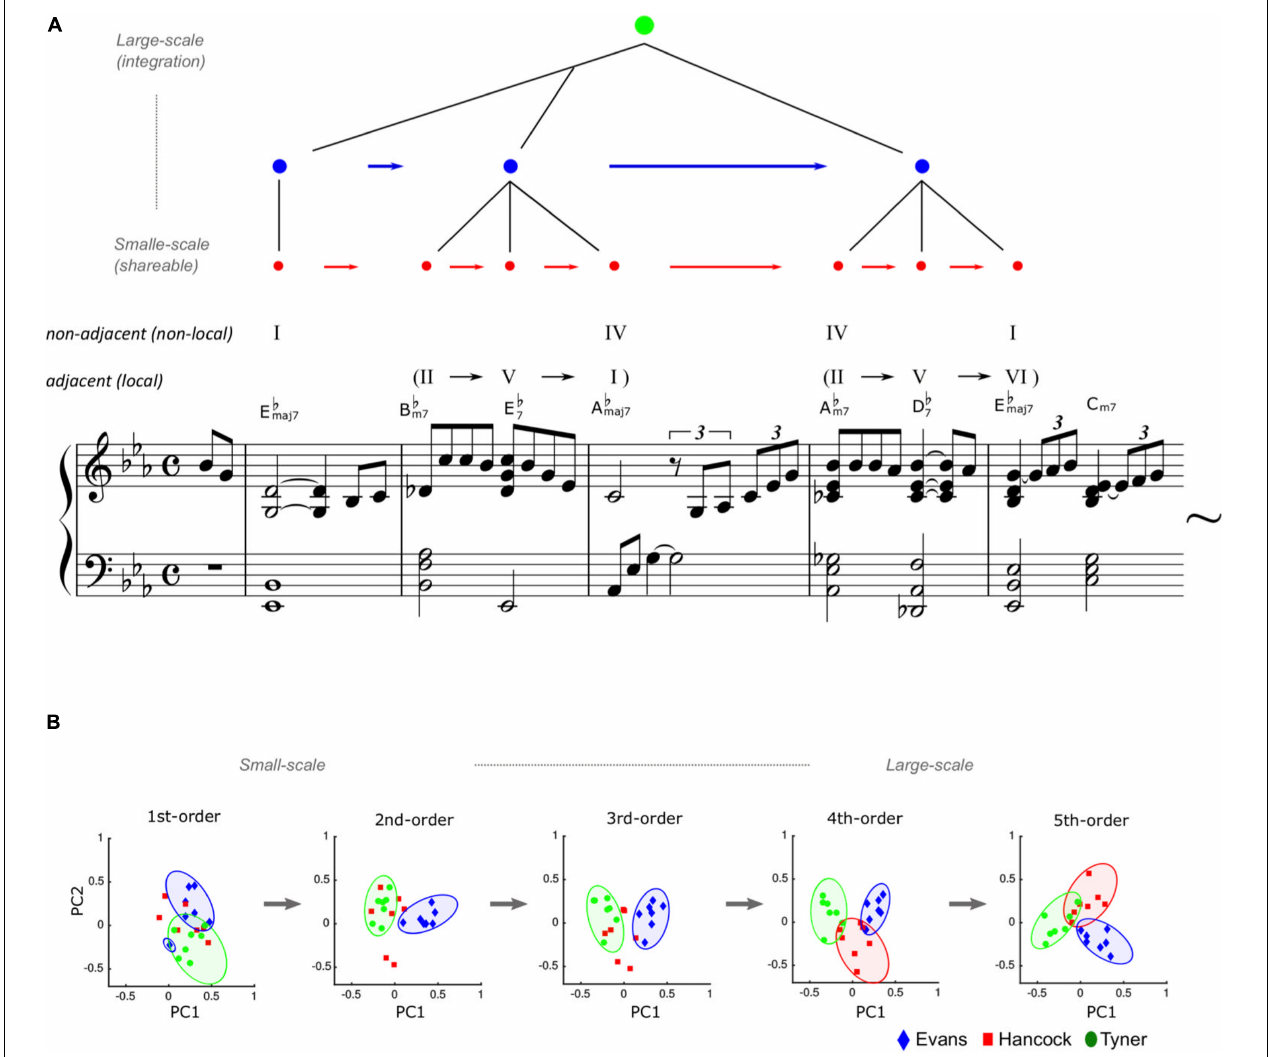
FIGURE 1 | Statistical creativity in musical improvisation. Misty by Errol Garner, composed in 1954. (A) The arrangement, chord names, and symbols are simplified (just major/minor, flat , and 7th note) to account for the two-five-one (II – V ( 7 ) –I ) progression. The statistical characteristics of jazz improvisation played by Bill Evans, Herbie Hancock, and McCoy Tyner. (B) Adapted from a figure of a previous article (Daikoku, 2018b). The component loading of principal component analyses showed that statistically coherent units have general characteristics shared among the three improvisors, whereas large-scale statistical units provide individualities unique to each improvisor. This suggests that abstraction (i.e., statistical learning within words) may fundamentally provide general knowledge, while integration (i.e., deep statistical learning between words) contributes to musical creativity and individuality, as well as common